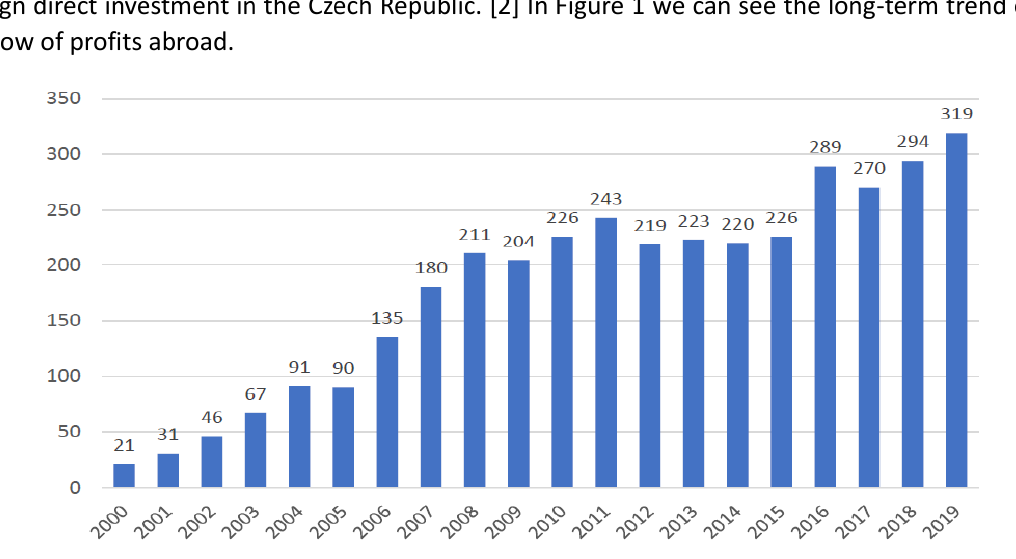
Figure 1: Outflow of profits from the Czech Republic abroad in billion CZK (source: The Czech Statistical Office, compilation of